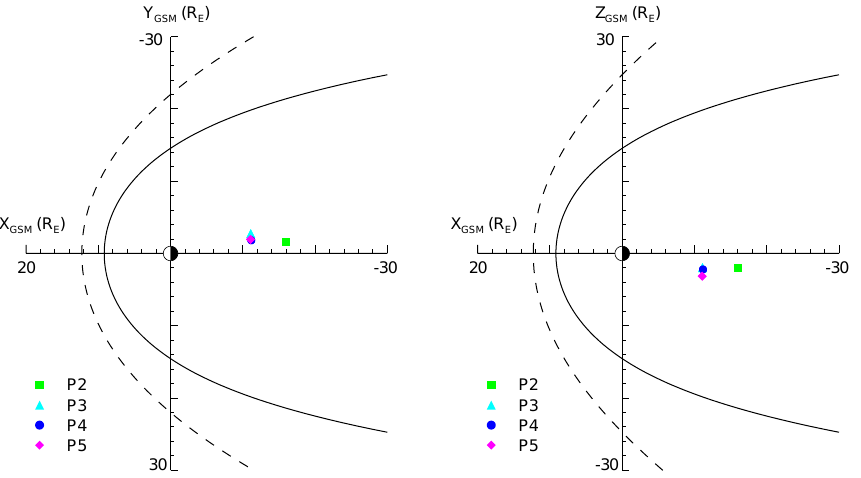
Fig. 2. The locations of four THEMIS satellites (P2, P3, P4 and P5) in the magnetosphere are shown in the GSM X-Y and X-Z planes. vortices in the plasma sheet generated the FAC of the sub- storm current wedge (SCW) at the beginning of the substorm expansion phase and coupled to the ionosphere, causing the ionospheric vortices. Based on the auroral images at 630 nm from all-sky imager (ASI) in Rankin Inlet, Lui et al. (2010) suggested that the plasma flow vortices could be related to an auroral streamer through